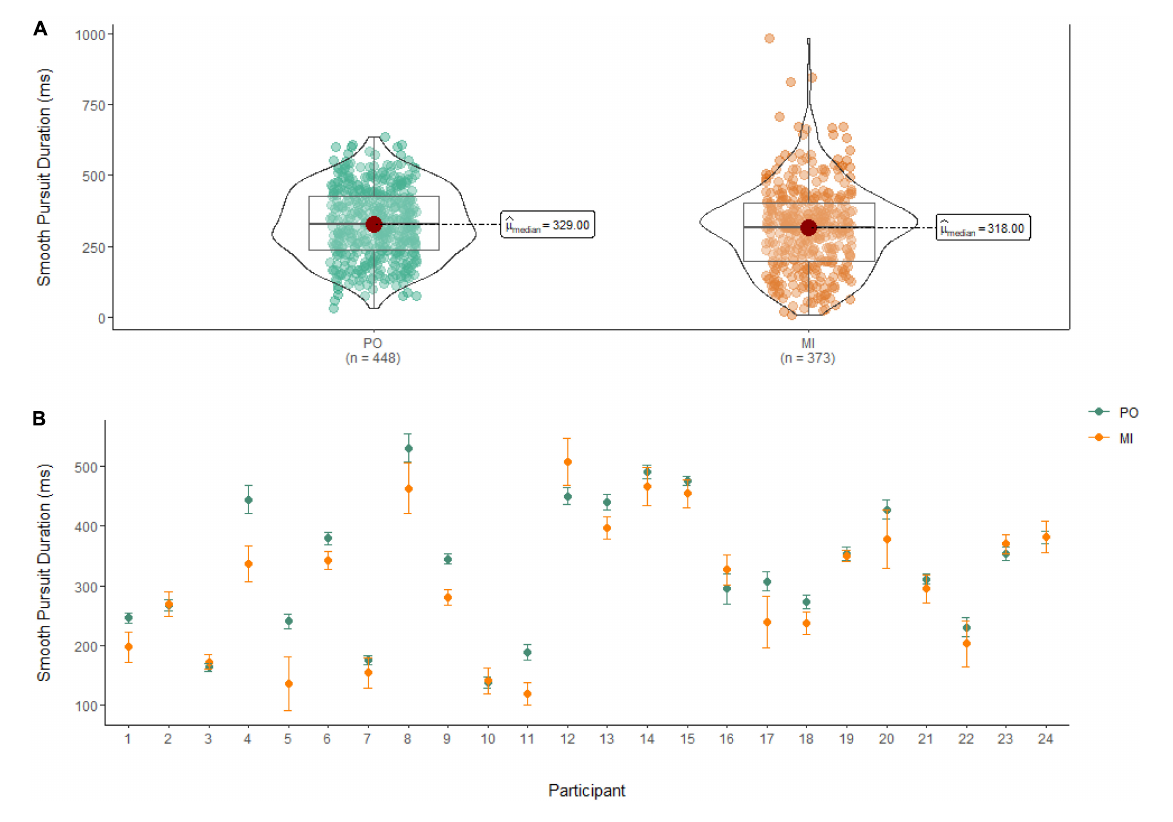
between MI and PO, W = 17,852, n = 389, p = 0.58. The